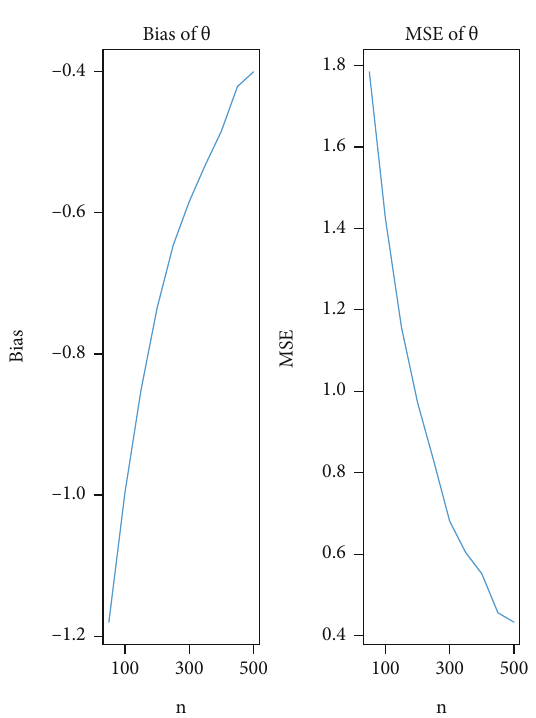
Figure 2: HRF graphs for the TLWE model.